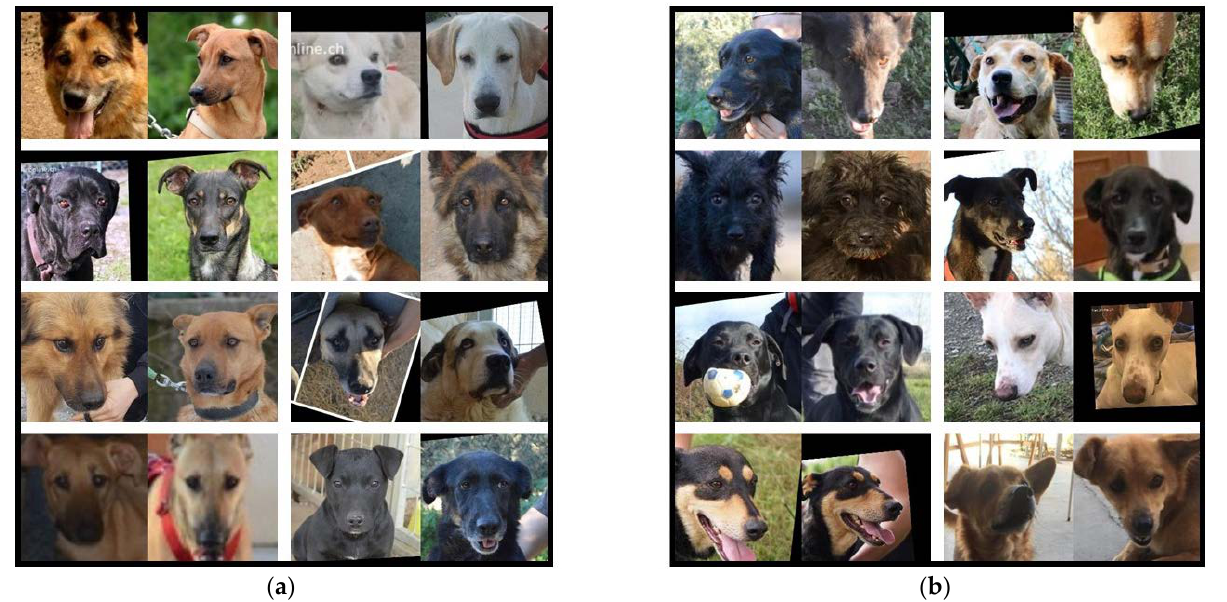
Figure 11. Example of face verification of the proposed learning method. ( a ) false-positive pairs; ( b ) false-negative pairs.